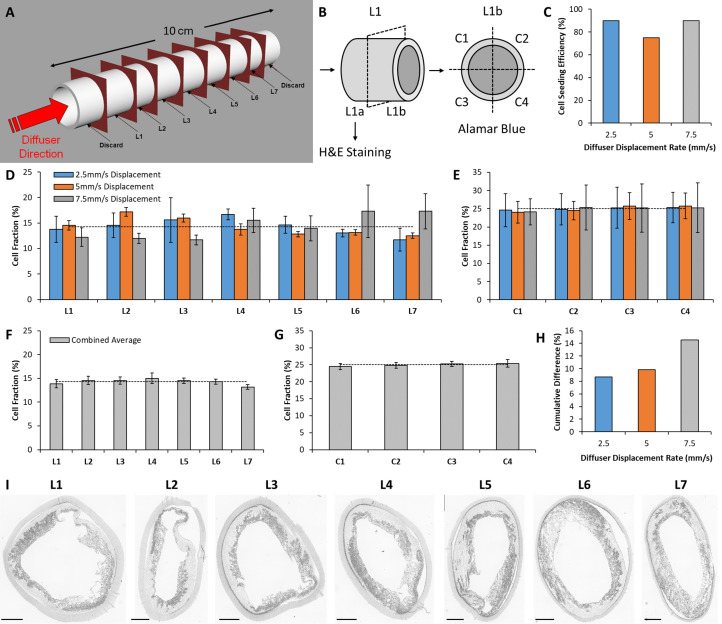
In vitro analysis of seeding device performance. (A) Schematic of the sectioning technique used to quantitatively assess the distribution of cells seeded within scaffolds using the novel seeding device. (B) Separation of each section for histological staining and metabolic activity assessment. Cell metabolic activity assay sections were further divided into quadrants to estimate circumferential cell distribution within the scaffold. (C) Scaffold seeding efficiency for each seeding configuration examined in this study. (D) Longitudinal distribution of cells across seven longitudinal sections for each seeding configuration. The dashed line indicates ideal cell distribution. (E) Circumferential distribution of cells across four quadrants for each seeding configuration. (F) Combined average of all three seeding configurations for longitudinal, and (G) circumferential distribution. (H) Cumulative difference between longitudinal cell distribution and the ideal distribution for each seeding configuration. (I) H&E staining of the seeded scaffold (seeded at a Diffuser displacement speed of 2.5 mm/s) to visualize the distribution of cells within the scaffold pores. Scale bars depict 1 mm.